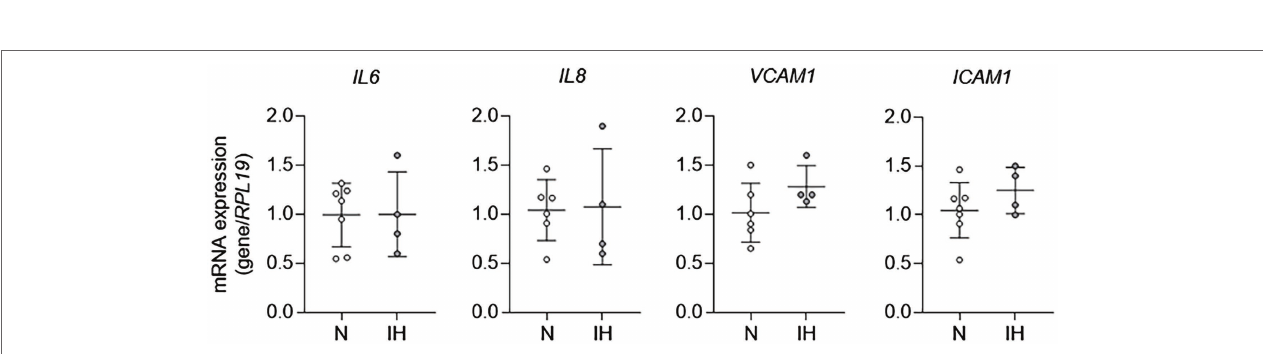
FIGURE 2 | Intermittent hypoxia alone fails to induce aortic EC activation in vitro . We exposed human aortic ECs to either normoxia (N) or IH for 60 cycles and then assessed EC activation by measuring mRNA expression of markers of EC activation genes, including IL6 , IL8, VCAM1 , and ICAM1. N = 4–6.